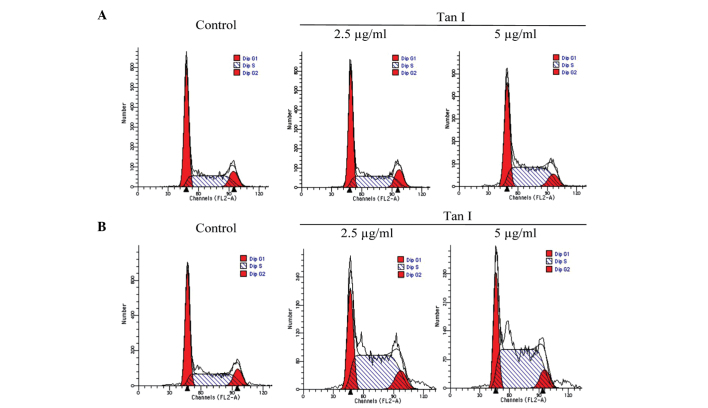
Effects of Tan I treatment for 48 h on the cell cycle distribution of breast cancer cells. (A) MCF-7 cells and (B) MDA-MB-453 cells. Tan I, tanshinone I.